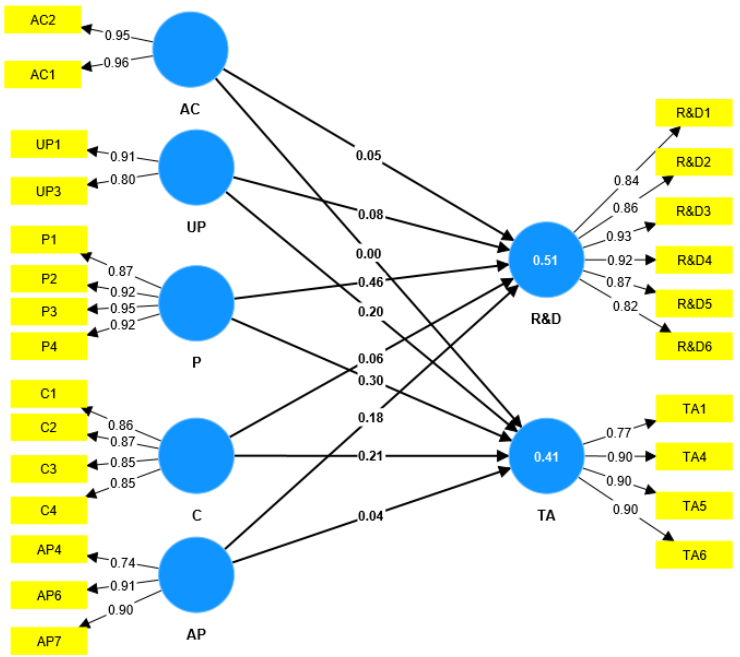
Figure 2. Model verification. Note: Source: own elaboration using data from Smart-PLS V.